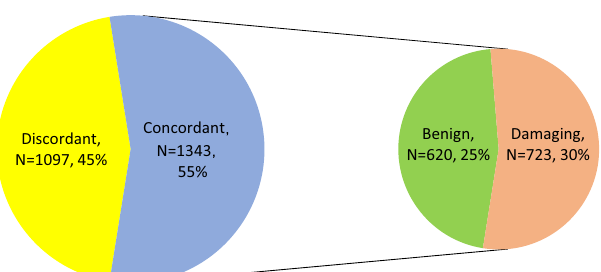
Figure 4. Summary of agreement in prediction outcomes for BRCA1 missense VUS.